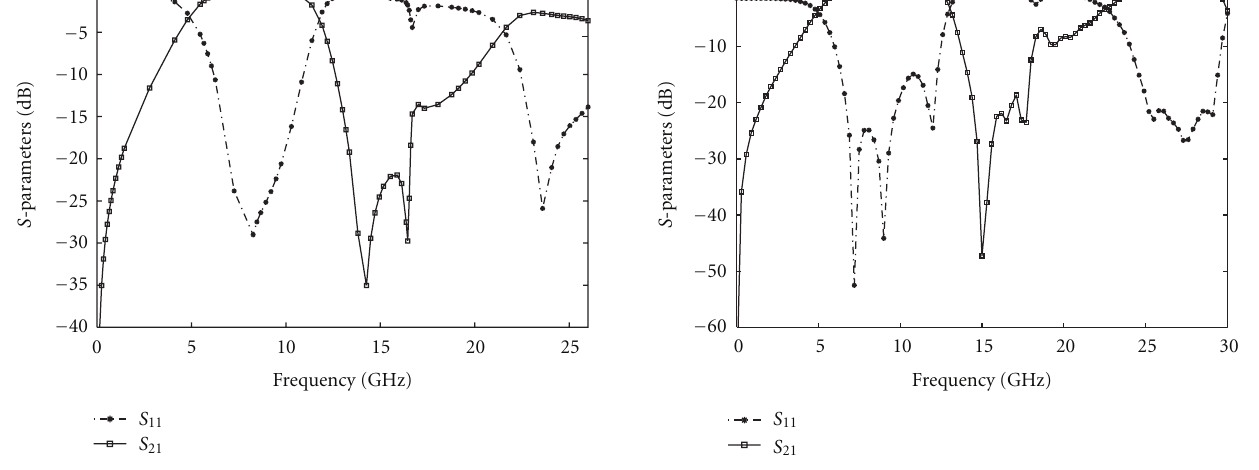
Figure 3: Scattering parameters for the DS-UC by MOM. s 1 = s 2 = 0 . 22mm; g 1 = g 2 = 0 . 1 mm, Δ = 0 . 1 mm, w 1 = 0 . 9 mm, w 2 = 1 . 34mm; l 1 = l 2 = 0 . 45 mm, l = 7 . 24 mm, h = 0 . 635 mm, ε r = 10 . 2.